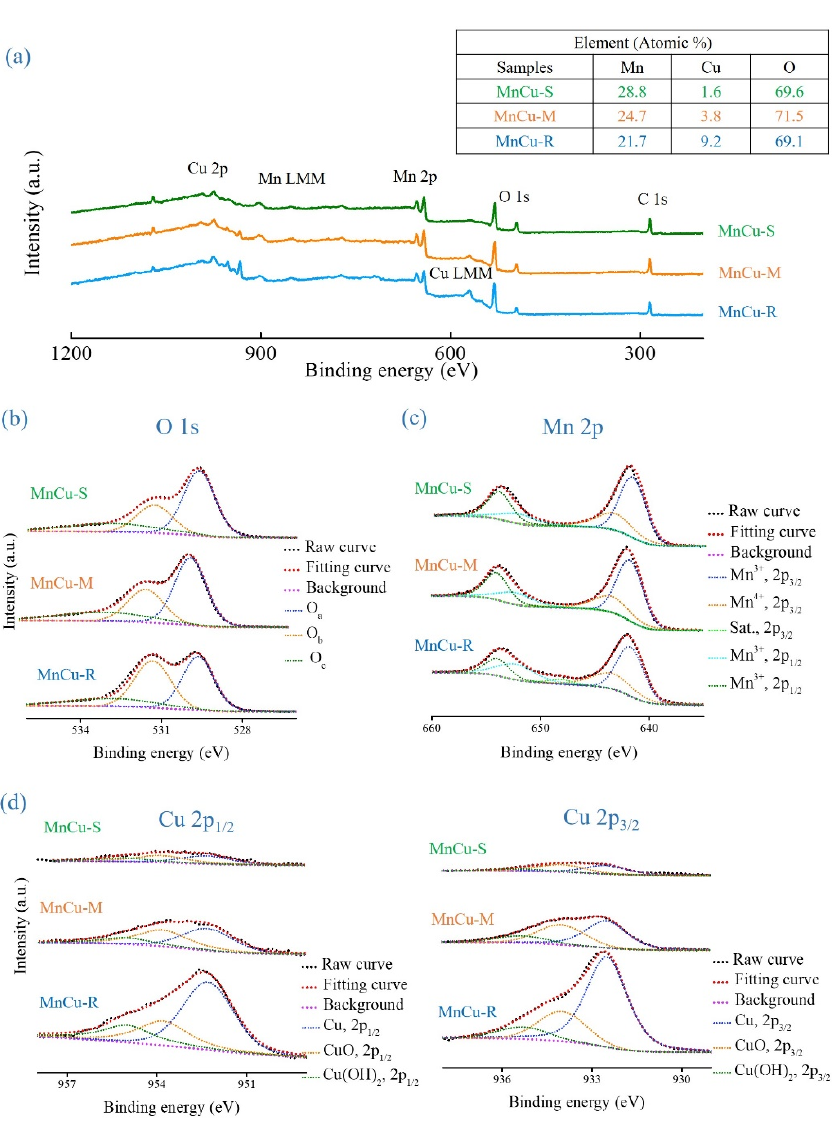
Figure 7. XPS spectra of MnCu-R, MnCu-M, and MnCu-S ( a ) full survey, ( b ) O 1s, ( c ) Mn 2p, and ( d ) Cu 2p 1/2 and Cu 2p 3/2